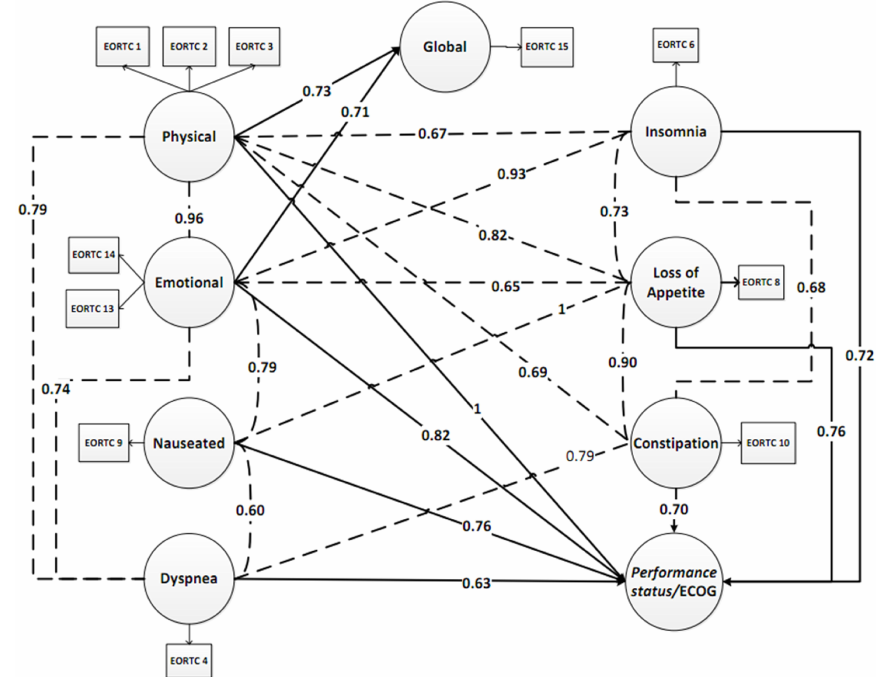
Fig. 5. Visualization of causal models of quality of life using the S3C-Latent method